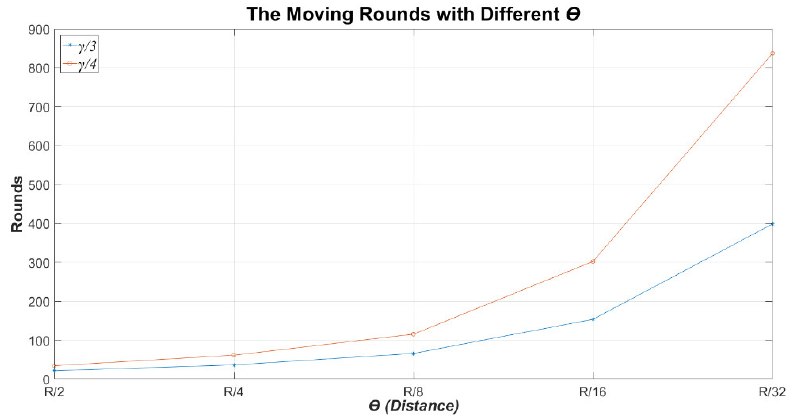
Figure 7. The number of Moving Rounds with Different Terminated Thresholds. Shortening the moving step size will increase the number of terminating rounds. When the terminating threshold grows, the number of moving rounds decreases. This is because the mobile sensors can quickly step into the stop status.